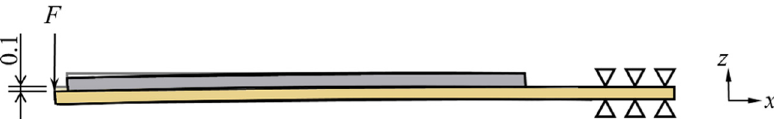
Figure 2: The boundary conditions.